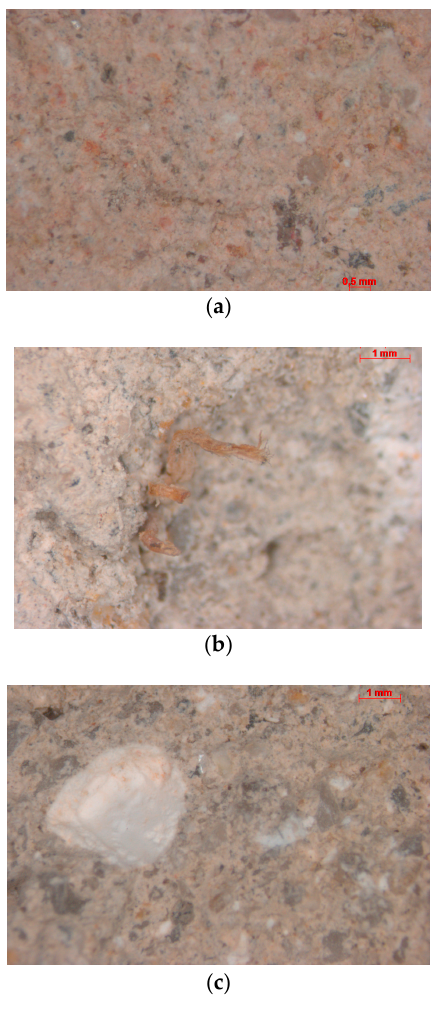
Figure 4. Macroscopic aspect of mortar samples S-002 ( a ), S-004 ( b ), and S-009 ( c ).